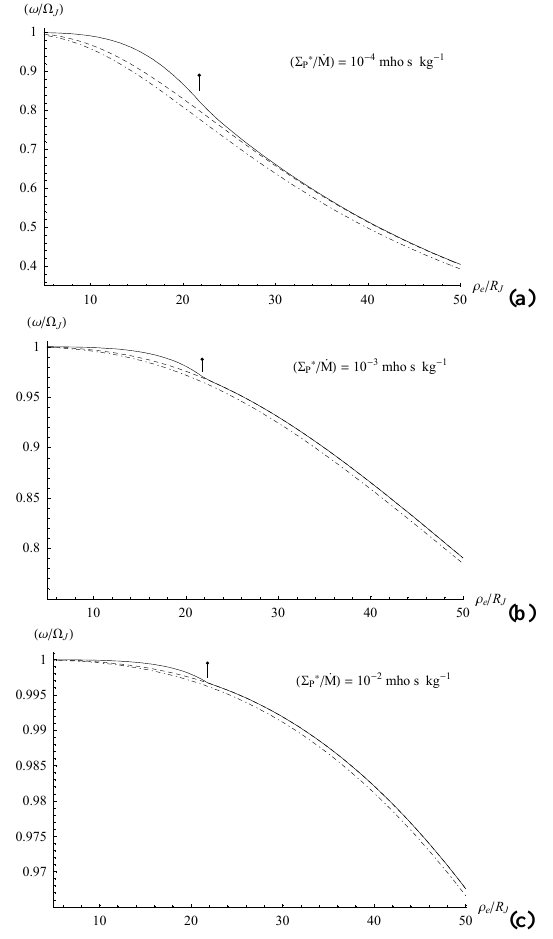
Fig. 5. Plots showing plasma angular velocity profiles versus equa- / ˙ M) equal to (a) 10 − 4 , (b) 10 − 3 , and torial radial distance for (6 ∗ P (c) 10 − 2 mhoskg − 1 . The solid lines show the solution obtained by numerical integration of Eq. (6b) using the full ‘current sheet’ mag- netic model shown in Fig. 4, starting from the near-rigid corotation approximation Eq. (8) at ρ e = 5R J . The tick marks show the point (ρ ∗ e ≈ 21.78R J ) where the magnetic field switches from the ‘CAN’ model to the power-law ‘KK’ model. The dashed lines then show the numerical solution obtained by employing the ‘KK’ power law field (given by Eqs. 24 and 25) over the full distance range, the so- lutions again being initialised using the appropriate form of Eq. (8) at ρ e = 5R J . The dot-dashed lines show the approximate analytic solution using the ‘KK’ power law field, given by Eq. (28) with K = 0 and m = 2 . 71. Note that the vertical scale has been tailored to the plot in each